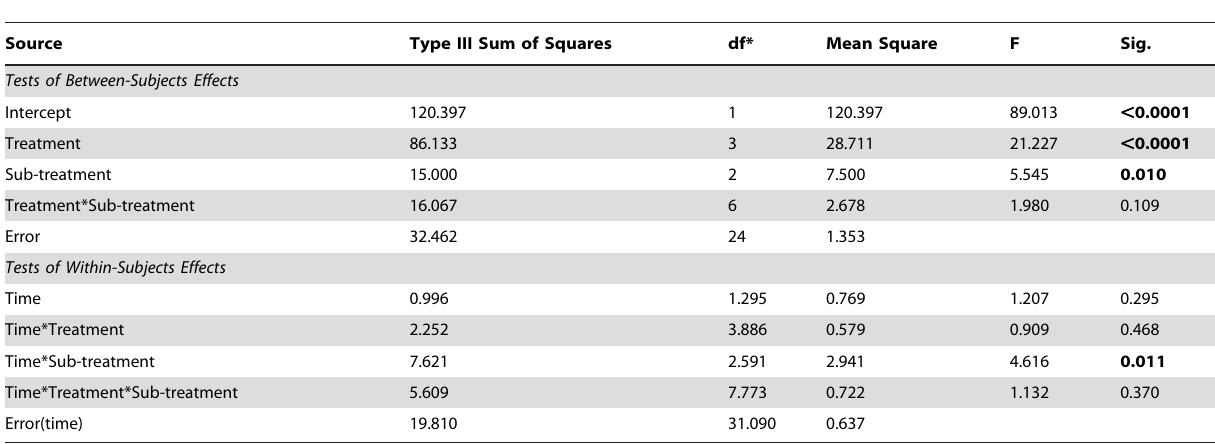
Table 3. Repeated-measures two-way ANOVA of the per capita effect magnitude with treatment (initial aphid densities), sub- treatment (‘‘Predators’’, ‘‘Predators + Parasitoids’’ and ‘‘Parasitoids’’), and time of the counting as main effects.